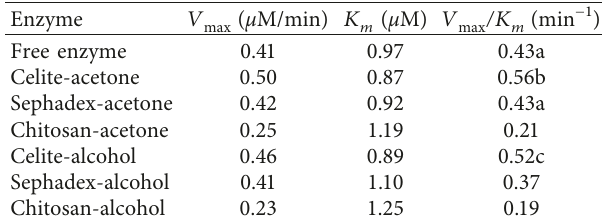
Table 2: Variation in the Michaelis–Menten constants.